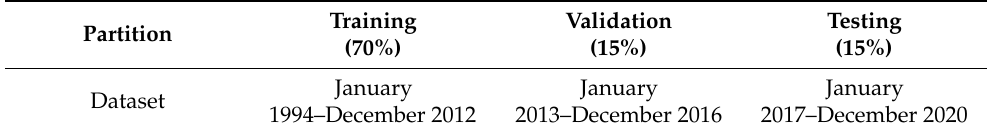
Table 2. Data partition breakdown with dates for the study sites.